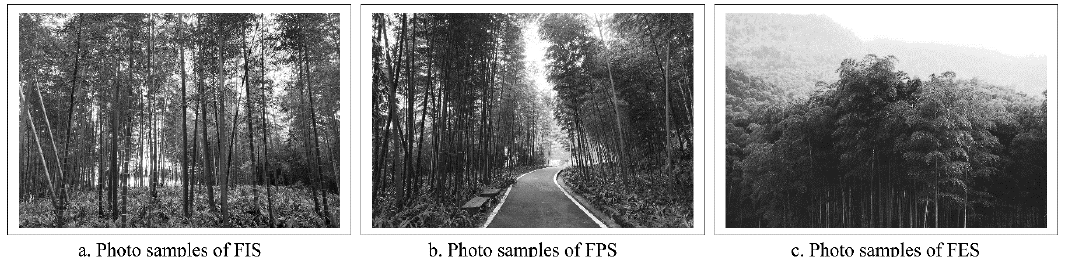
Figure 2. Photo samples of three bamboo forest spaces.